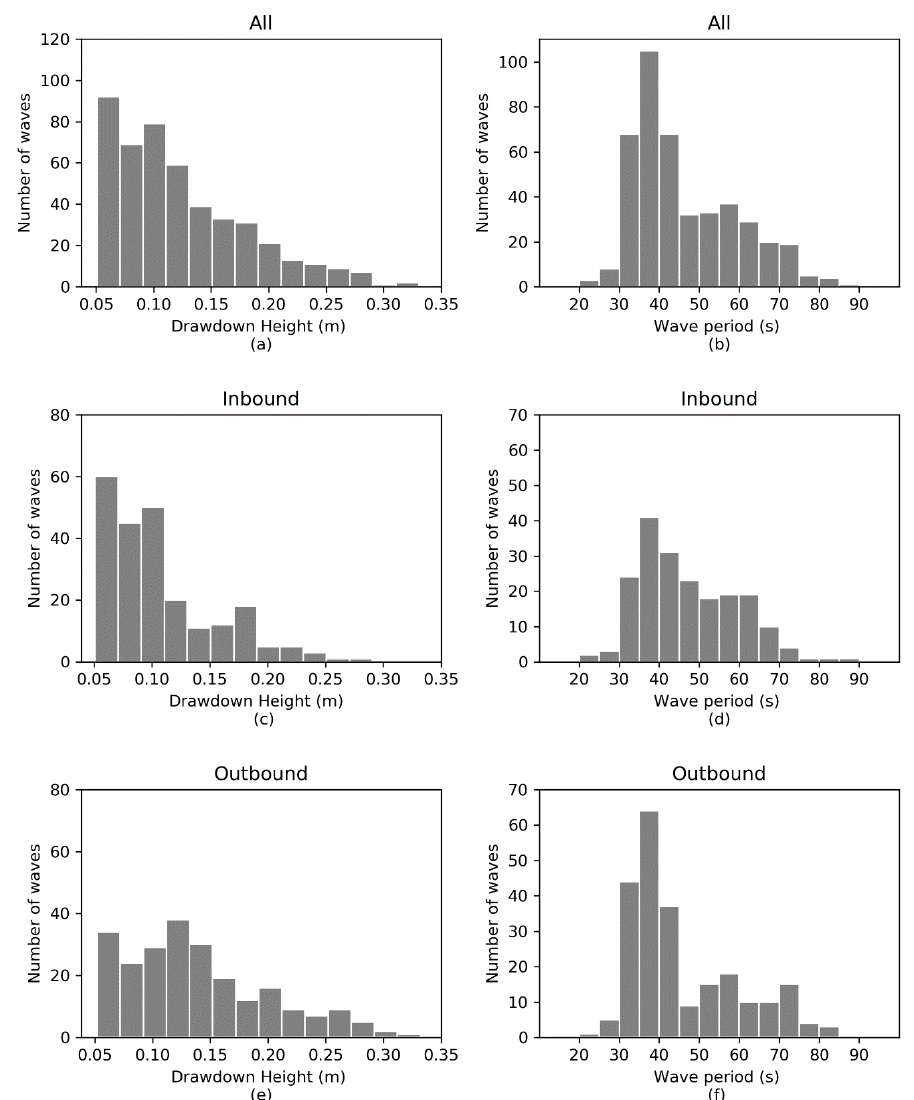
Figure 5. ( a ) Histogram of drawdown height at Nykvarnsholme and Björnhuvud for all inbound and outbound ship passages. ( b ) Histogram of wave period for all ship passages. ( c ) Histograms of drawdown height for inbound traffic. ( d ) Histograms of wave period for inbound ships. ( e ) Histograms of drawdown height for outbound ship passages. ( f ) Histograms of wave period for outbound ships.